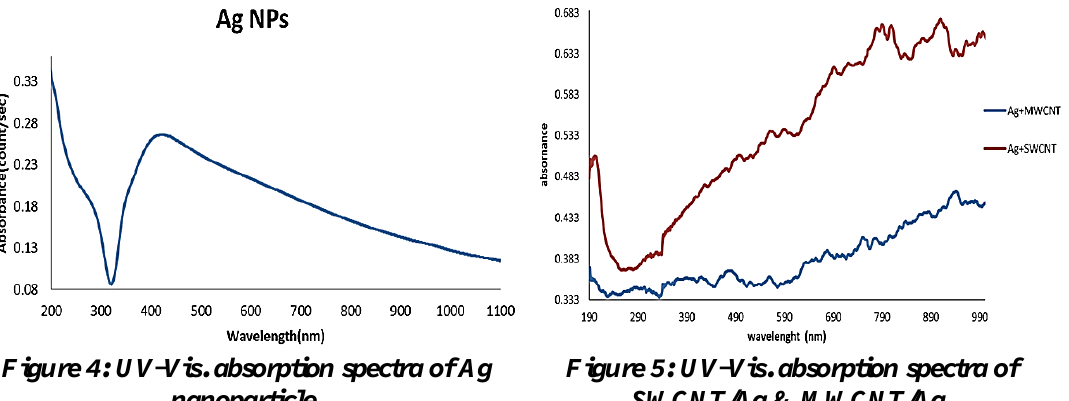
Figure 5: UV-Vis. absorption spectra of SWCNT/Ag &